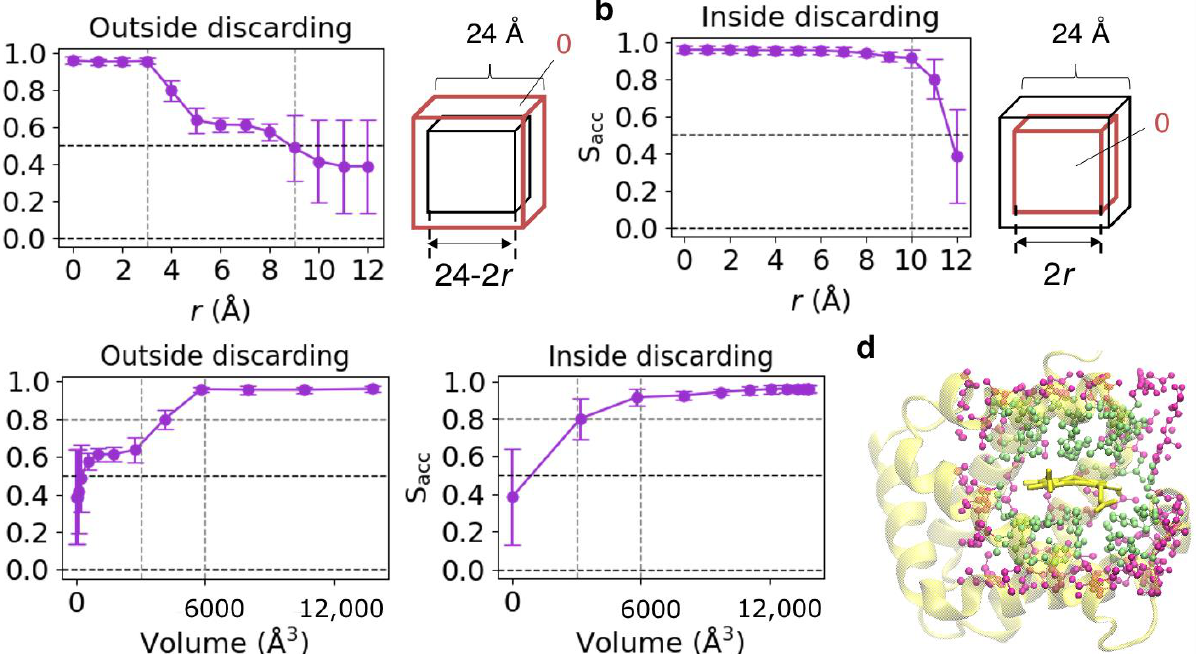
Figure 3. ( a ) Mean S acc scores plotted against r , which is the distance between the faces of the outer (red) and inner (black) cubes presented in the right panel for “outside discarding.” The error bar shows the standard deviation. The centers of the outer and inner cubes are identical, and their edges are parallel. ( b ) Mean S acc scores plotted versus r for ”inside discarding.” ( c ) S acc scores versus the volume of the region with the original information. ( d ) Atoms included in cube-shaped regions with an edge length of l are illustrated using the PDB entry of 1A00 as an example. The lime spheres and the combination of lime and magenta spheres represent l = 18 and 24, respectively. The main chain of the host protein is shown as a yellow cartoon, and heme as a yellow